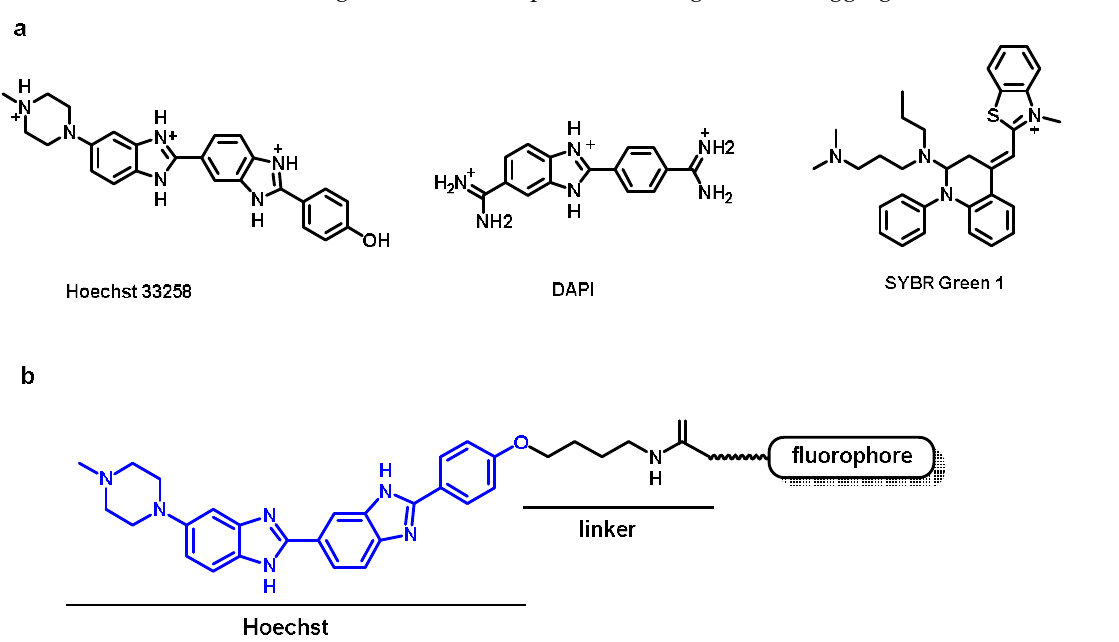
Figure 2. ( a ) Structures of Hoechst 33258, DAPI and SYBR Green 1. ( b ) Nucleus-targeted fluorescent probe design strategy based on Hoechst.